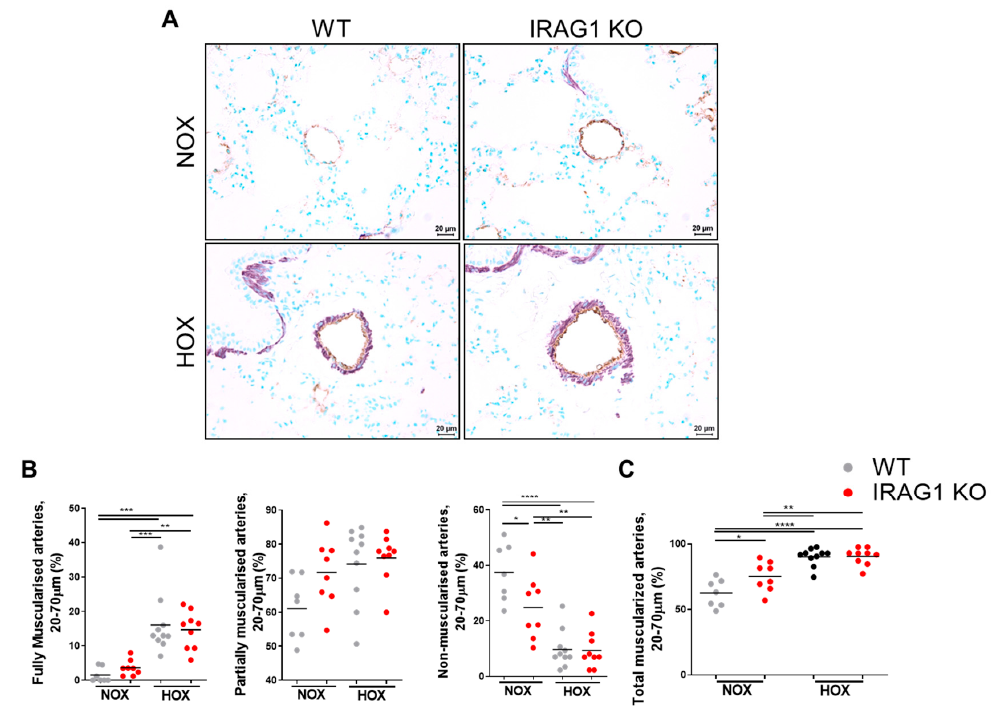
Figure 3. Disruption of IRAG1 gene in mice showed pulmonary artery remodeling in normoxic conditions. ( A ) Formalin fixed paraffin embedded lung sections were immunostained for α -SMA (alpha-smooth muscle actin, violet) and vWF (von-Willebrand factor, brown). Bars indicate 20 µm. ( B ) Quantification of the relative percentage of fully, partially, and non-muscularized arteries were performed. Each group is represented as percentage of the total number of arteries counted. ( C ) Total muscularized arteries were quantified as the percentage of arteries that had any muscularization and represented as percentage of the total number of arteries counted. Number of animals used: ( A – C ) Normoxia—seven WT and eight IRAG1 KO, hypoxia—10 WT and 9 IRAG1 KO. All quantified data were represented as individual point and bar indicated the mean, * p < 0.05, ** p < 0.01, *** p < 0.001, **** p < 0.0001, comparison of multiple groups were performed by one-way ANOVA, followed by Tukey’s multiple comparisons test between the groups.